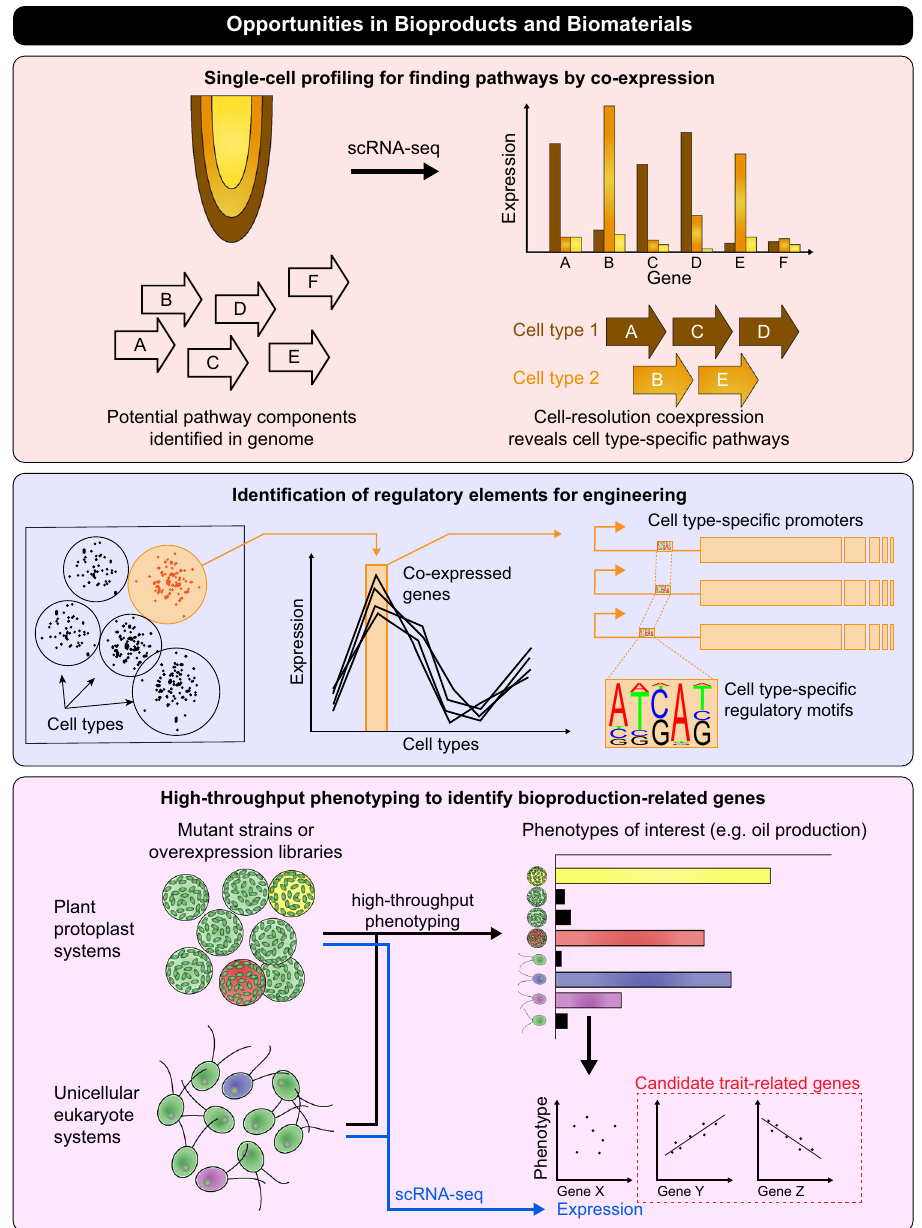
Fig. 4 Using single-cell methods in bioproducts and biomaterials applications. Top panel: single-cell resolution data can be used to fi nd genes in biosynthesis pathways by identifying co-expressed genes in individual cells or cell types. Middle panel: single-cell expression data can identify cell-speci fi c and condition-speci fi c building blocks, as genes that co-vary across clusters of cells are likely regulated by common components (e.g., transcription factors). This can be exploited to identify promoters useful for bioengineering applications where production in a speci fi c cell type is desired. Bottom panel: improvements to bioproduction targets in plant or algal systems could be achieved through correlating high-throughput phenotyping and single-cell resolution “ omics ” data. High-throughput analyses of mutant strains or libraries containing engineered biosynthetic clusters could be used to identify or verify which genes and pathways are necessary for the production of speci fi c products and to optimize for higher production